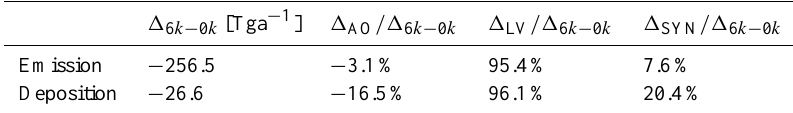
Table 7. Total difference in dust emission in North Africa (17 ◦ W–40 ◦ E; 10–30 ◦ N) and dust deposition along the northwest African margin (30–17 ◦ W; 5–35 ◦ N) between 6 k and 0 k and percentages of land surface conditions, atmosphere-ocean conditions and synergy effects to the total